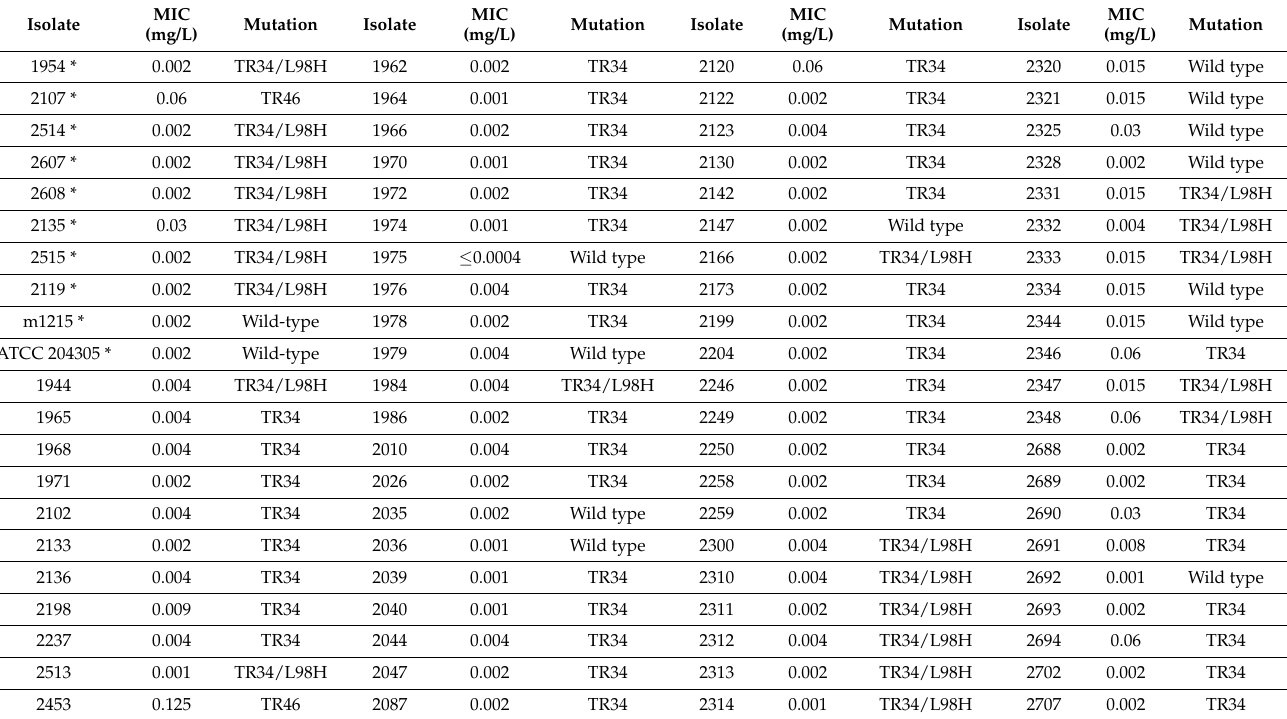
Table 1. List of all the A. fumigatus isolates used in this study, with isolate specific MIC ( µ g/mL) values of LLCZ and their characteristic mutations. Strains marked with an asterisk * were used in subsequent